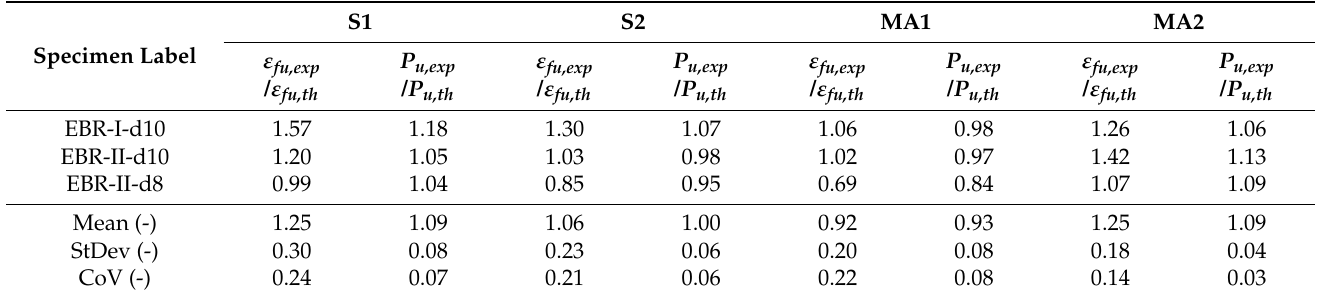
Table 4. Experimental results versus theoretical predictions for tested beams.